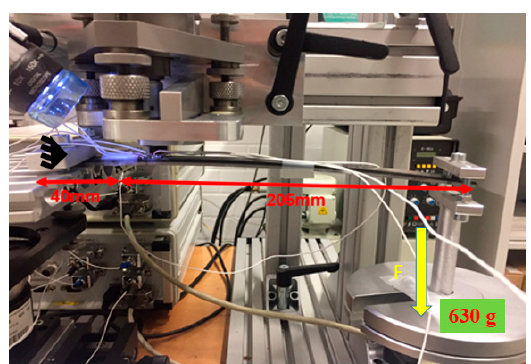
Figure 12. Experimental set-up used for validating the reliability of residual stress measurements.